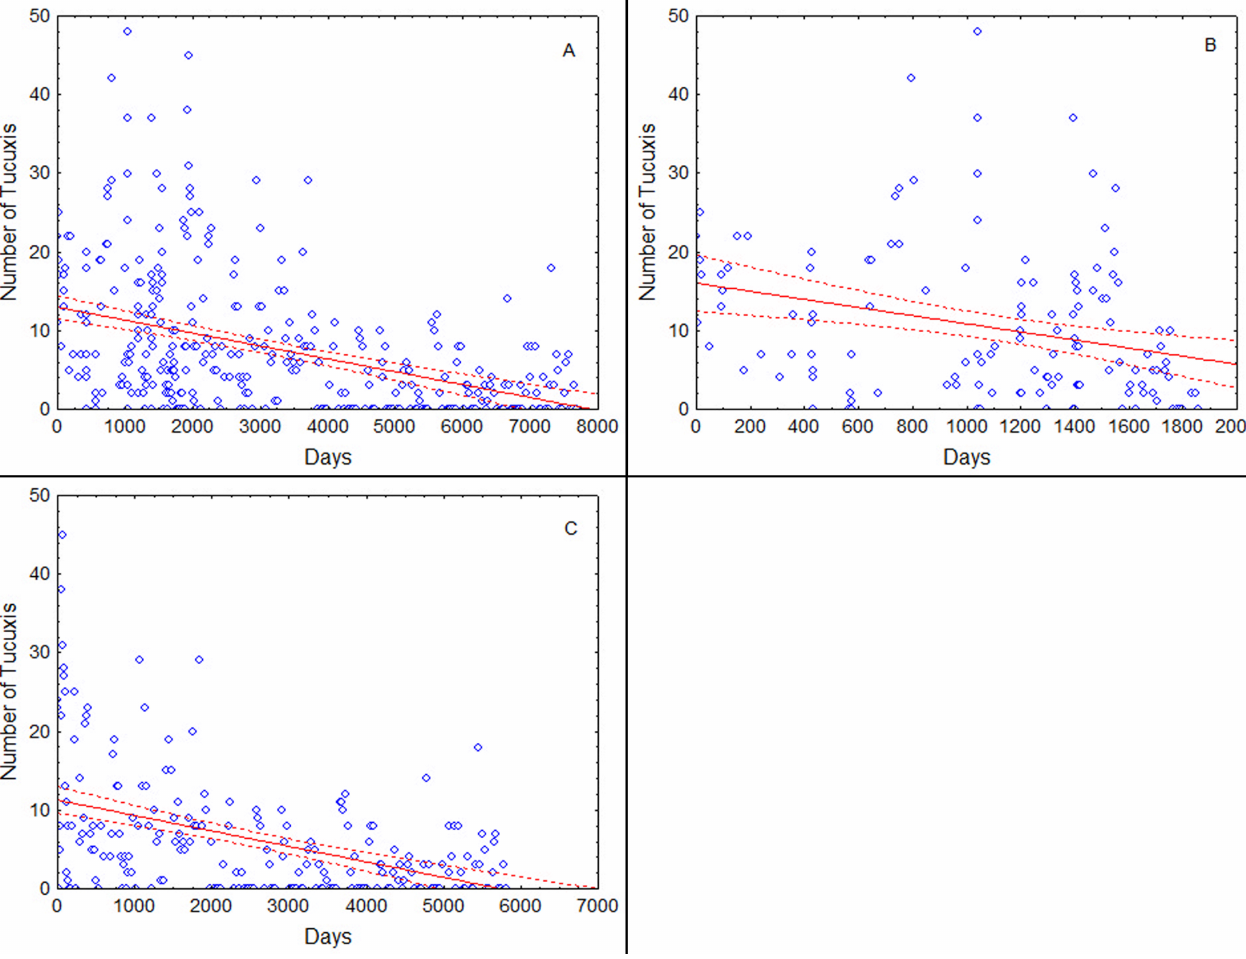
Fig 3. Scatterplots of the number of observed tucuxis per survey as a function of time, including the trend line and 95% confidence intervals estimated by the model. (A) Entire study (Nov 1994—Jan 2017); (B) Nov 1994—Dec 1999; (C) Jan 2000—Jan 2017.